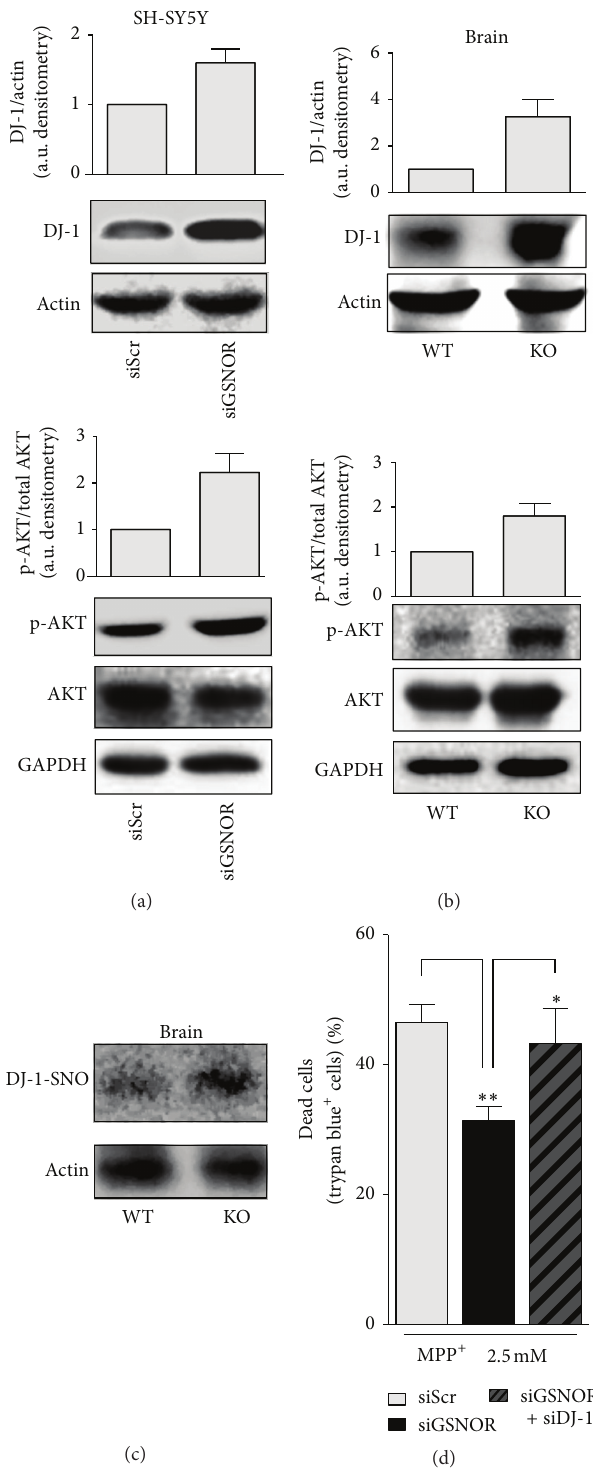
Figure 4: DJ-1 and AKT in siGSNOR cells and GSNOR-KO brains. Western blot analyses of DJ-1, as well as basal and phosphoactive AKT in total extracts obtained from (a) siScr and siGSNOR SH-SY5Y cells or (b) GSNOR-KO and WT brains. Densitometric analyses of DJ-1 and phospho-AKT are shown on the top of the corresponding Western blot normalized to actin and basal AKT, respectively. (c) Biotin switch assay followed by pull-down with streptavidin and revealed with anti-DJ-1 antibody, in total extracts obtained from GSNOR-KO and WT brains. Western blot analysis indicates that DJ-1 was S -nitrosylated (present in the pull-down). Western blots shown are representative of at least 𝑛 = 3 independent experiments that gave similar results. Actin or GAPDH were selected as loading controls. (d) Direct cell count upon Trypan blue staining of siScr and siGSNOR SH-SY5Y cells transfected or not with siRNA against DJ-1 (siDJ-1) and treated for 24 h with 2.5 mM MPP + . Graphs shown represent the mean of data ± SD of 𝑛 = 3 independent experiments, ∗ 𝑃 < 0.05 and ∗∗ 𝑃 < 0 .